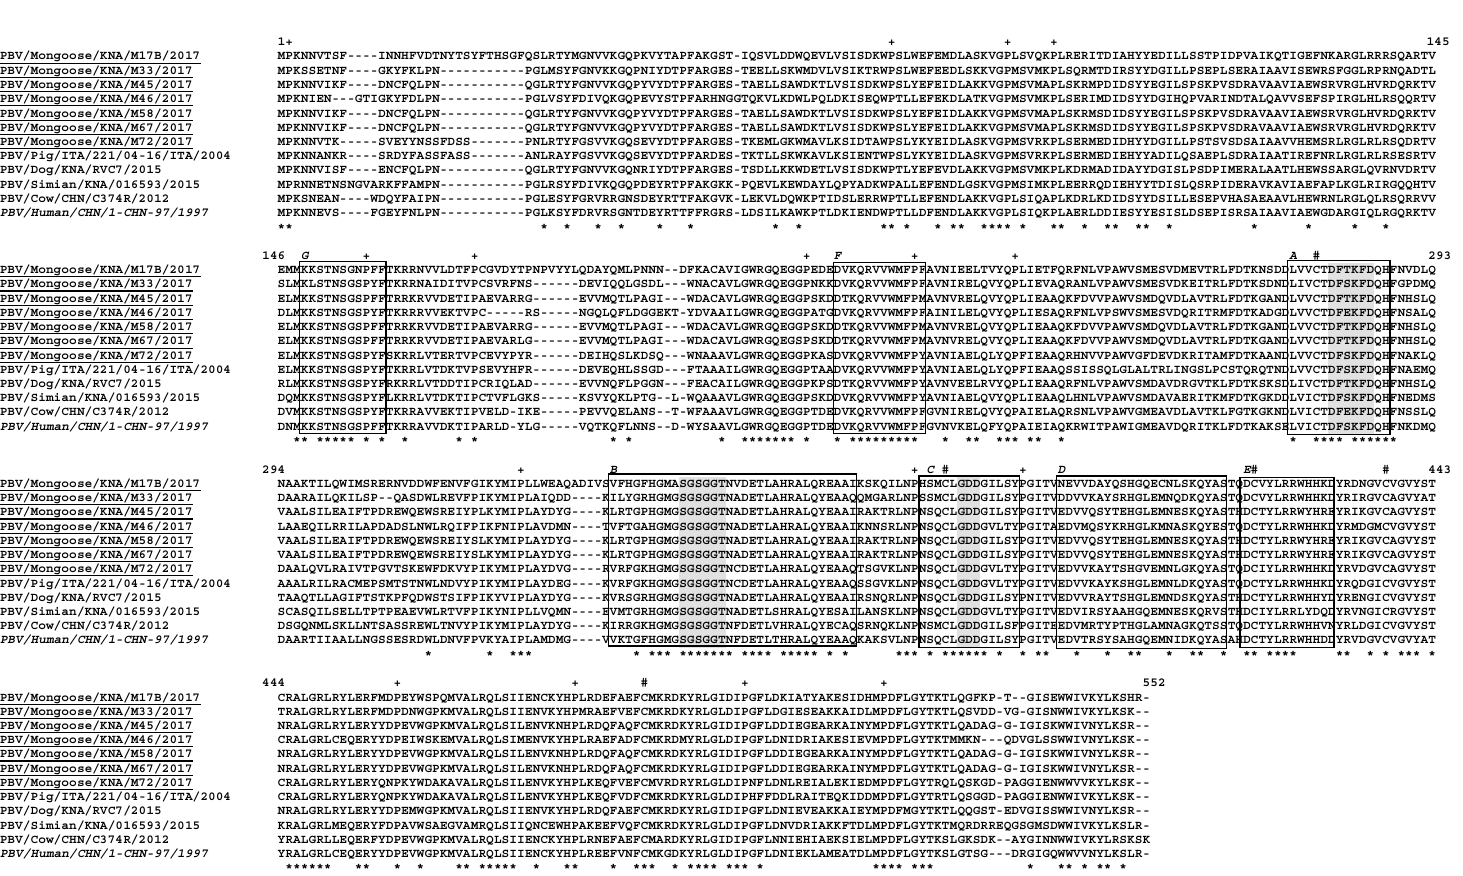
Figure 4. Alignment of the complete deduced amino acid (aa) sequences of putative RNA-dependent RNA polymerases (RdRps) of picobirnavirus (PBV) genogroup-I (GI) strains detected in the small Indian mongoose on the Caribbean island of St. Kitts with those of PBV strains from other host species using the ClustalW program (http://clustalw.ddbj.nig.ac.jp/, accessed 15 October 2019). The PBV strains from mongoose are highlighted with underlines, whilst the prototype GI strain PBV/Human/CHN/1-CHN-97/1997 is indicated by italic type . The three conserved domains in the putative RdRps are highlighted with gray, whilst the seven polymerase motifs (G, F, A, B, C, D, and E) are shown with boxes [27]. Conserved cysteine and proline residues are shown by ‘#’ and ‘+’, respectively. A ‘*’ denotes an identical aa residue, whilst ‘-’ indicates absence of an aa residue. Positions of aa residues correspond to those of PBV strain PBV/Mongoose/KNA/M17B/2017.